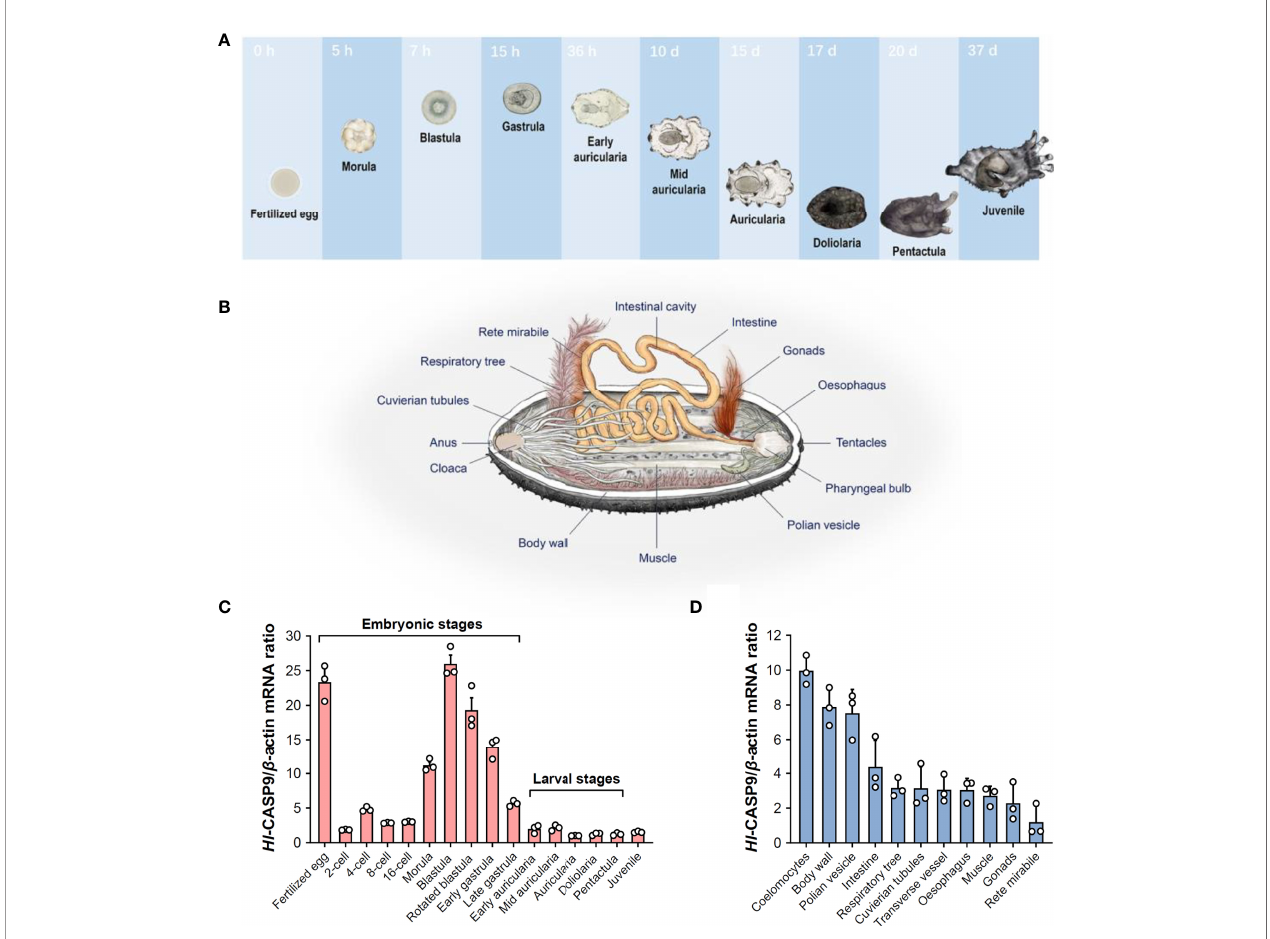
FIGURE 3 | Spatial and temporal expression patterns of Hl-CASP9 mRNA in developing embryos and adult tissues. (A) Typical embryonic and larval development of H. leucospilota . Numbers indicate time lapsed post-fertilization. (B) Anatomy of H. leucospilota . (C) Hl-CASP9 mRNA expression pro fi les in developing embryos and larvae of H. leucospilota . (D) Hl-CASP9 mRNA expression pro fi les in different adult tissues of H. leucospilota